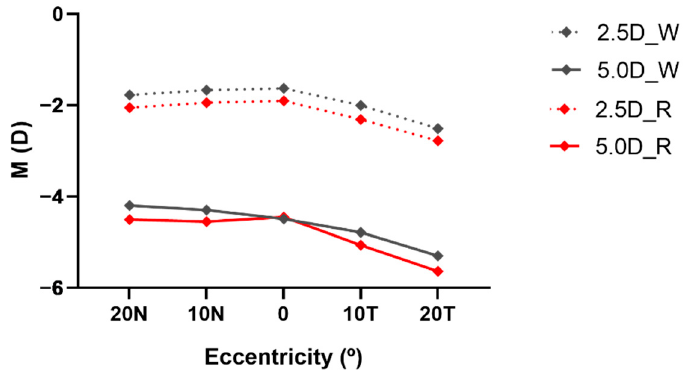
Figure 5. Spherical equivalent as a function of eccentricity for 2.5 D (dotted lines) and 5 D (solid lines) accommodative demands (W: white light; R: red light; N: nasal retina; T: temporal retina). Table 1 summarizes mean spherical equivalent results for each examination condition. The differences obtained between white and red light conditions manifest a statistically